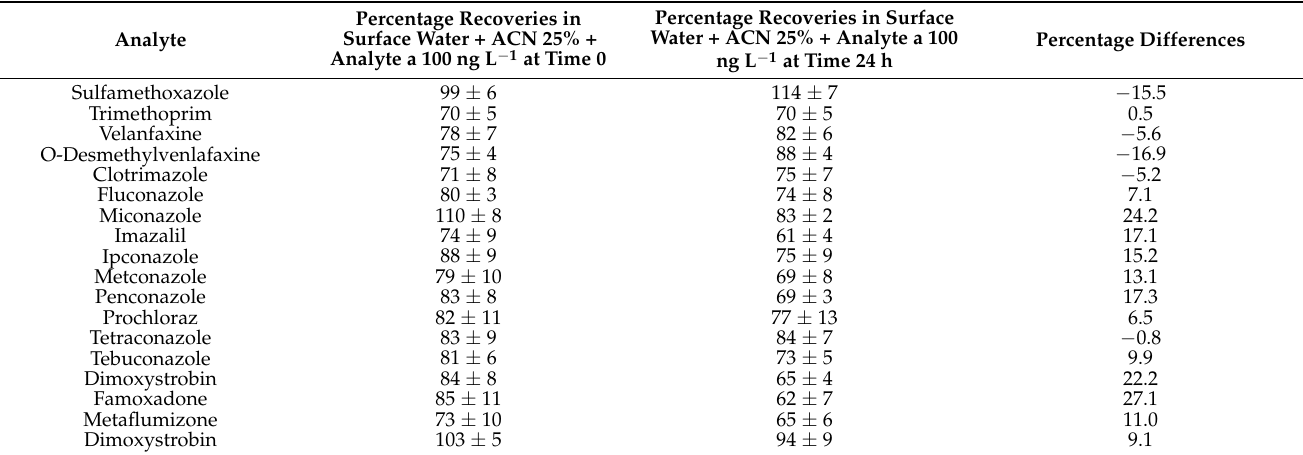
Table 7. Percentage differences about analysis performed at t0 and after 24 h.